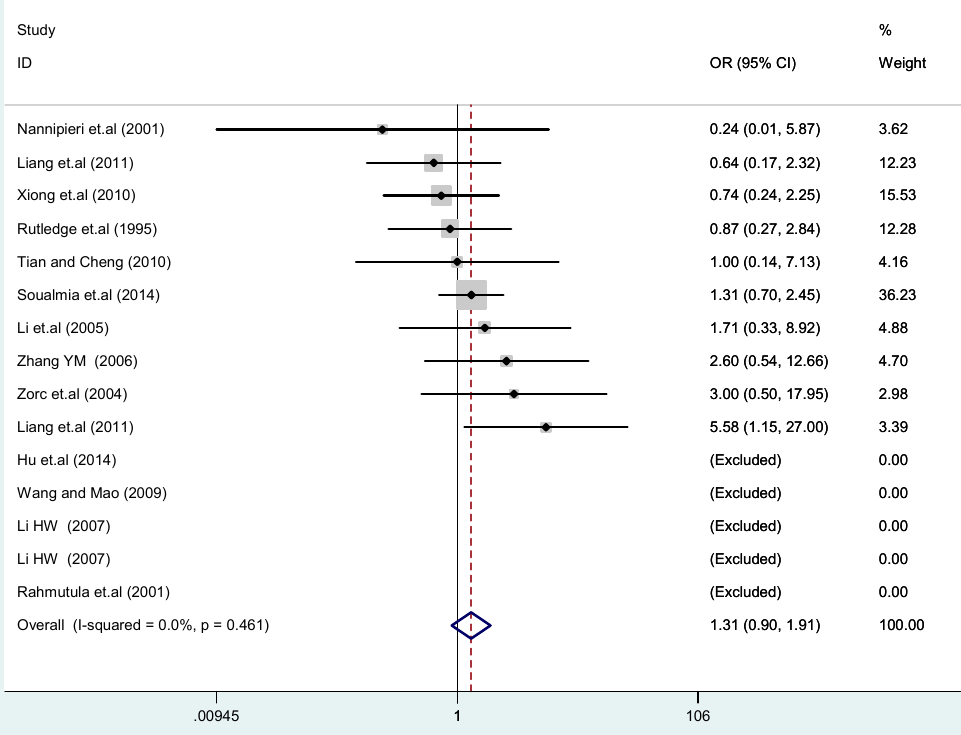
Overall (I-squared = 0.0%, p =